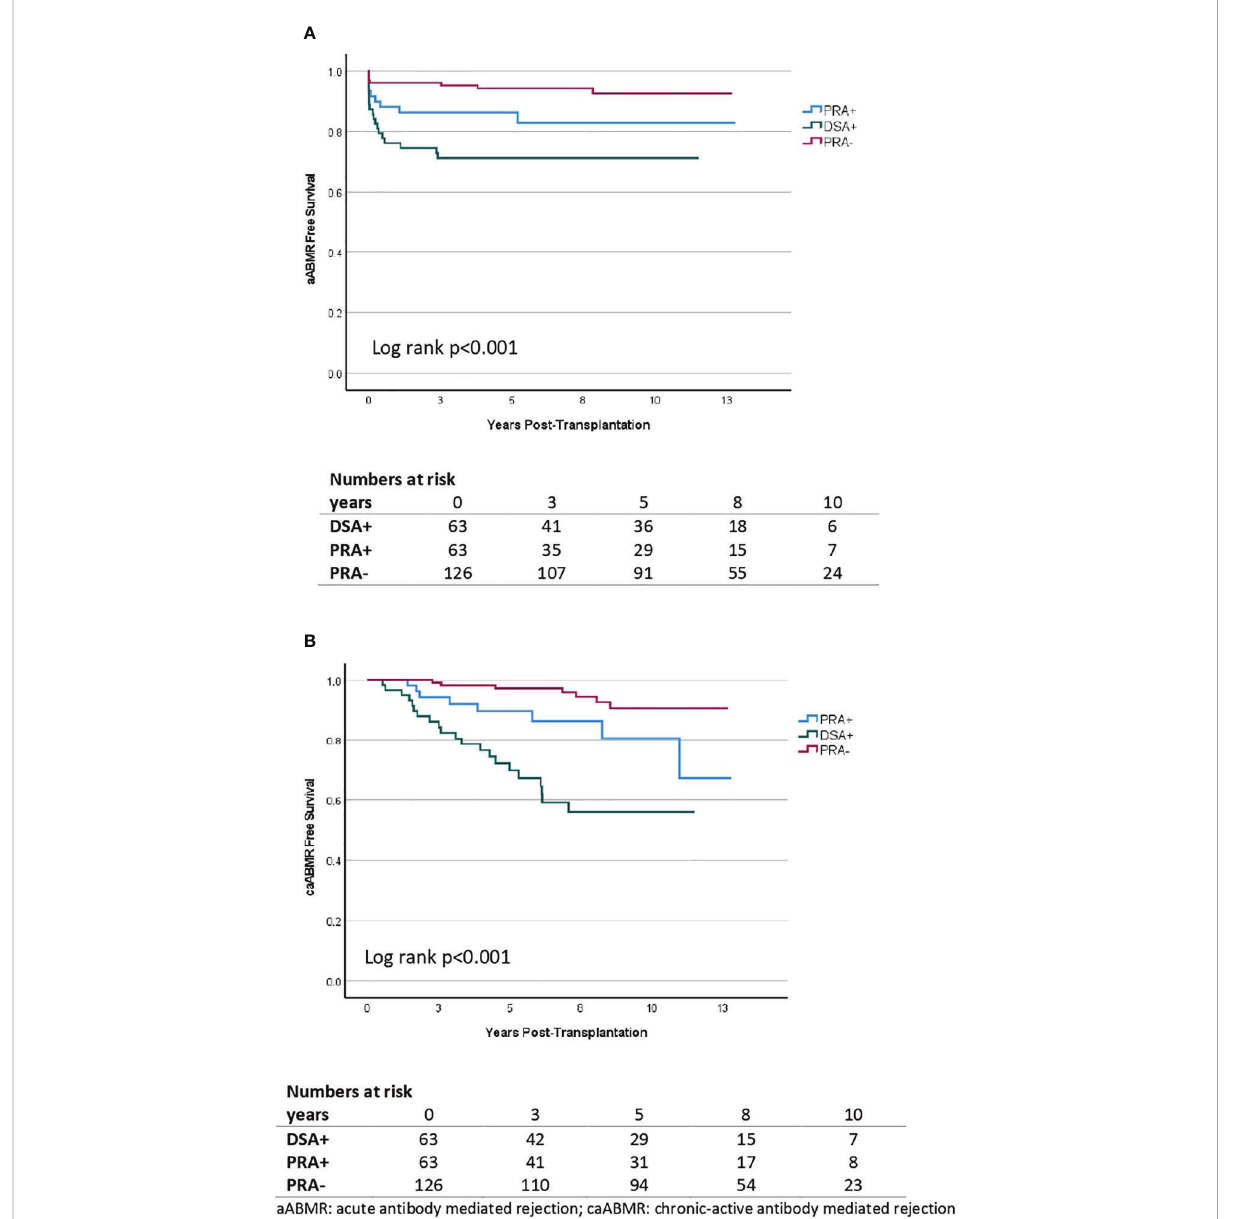
FIGURE 2 Kaplan Meier survival analysis of acute antibody mediated rejection (A) and chronic active antibody mediated rejection (B) in living donor kidney transplantation according to the presence and type of pretransplant anti-HLA antibodies. A comparison is made between donor-speci fi c antibody (DSA) positive individuals (DSA+, n=63), highly immunized individuals (PRA+, n=63) and non-immunized individuals (PRA-, n=126). The y-axis represents the proportion of patients alive with a functioning graft without aABMR/caABMR. The x-axis represents the days